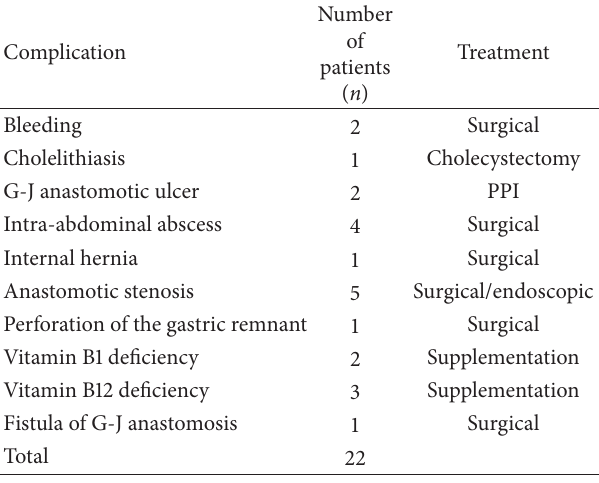
Table 3: Complications other than DS after